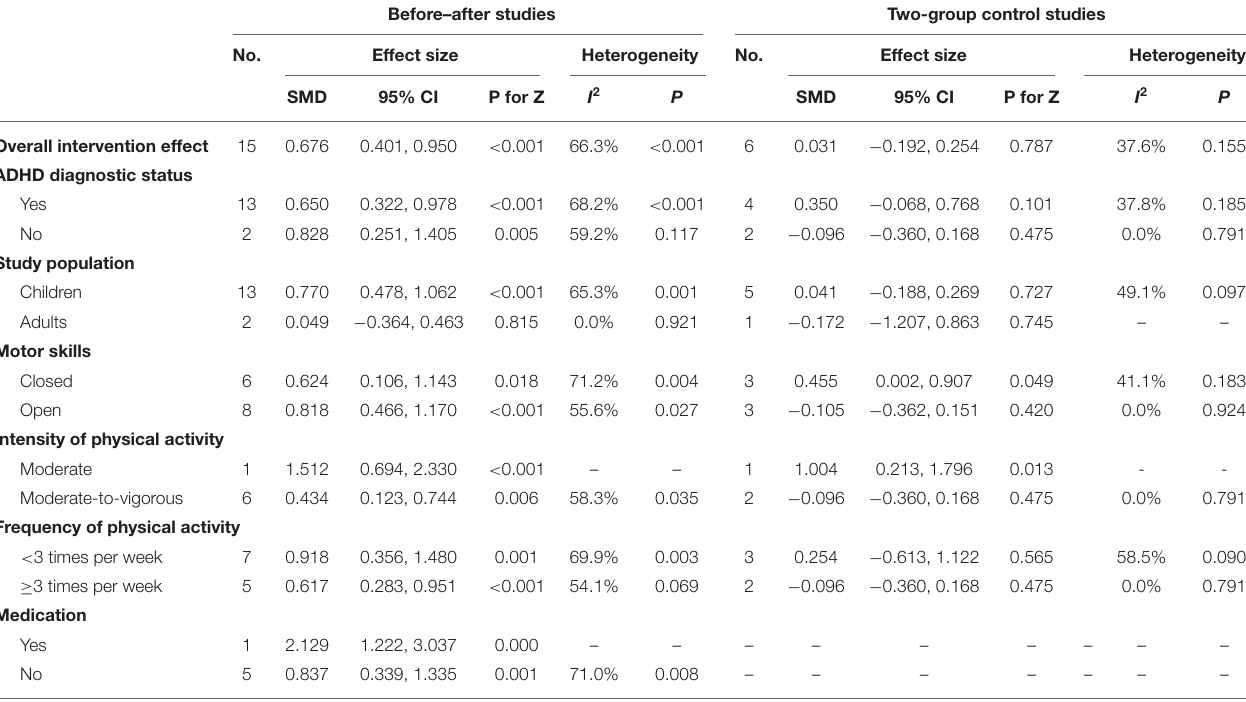
TABLE 3 | Pooled effect size for physical activity intervention on hyperactive/impulsive